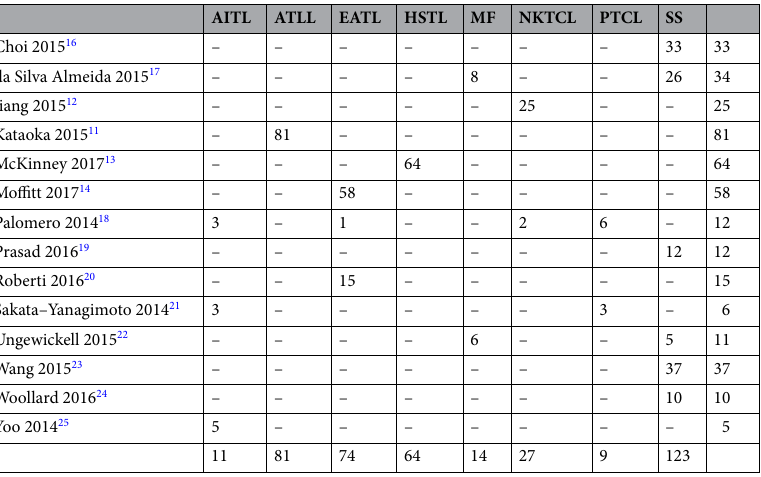
Table 1. Details of the studies included and the number of samples with each disease